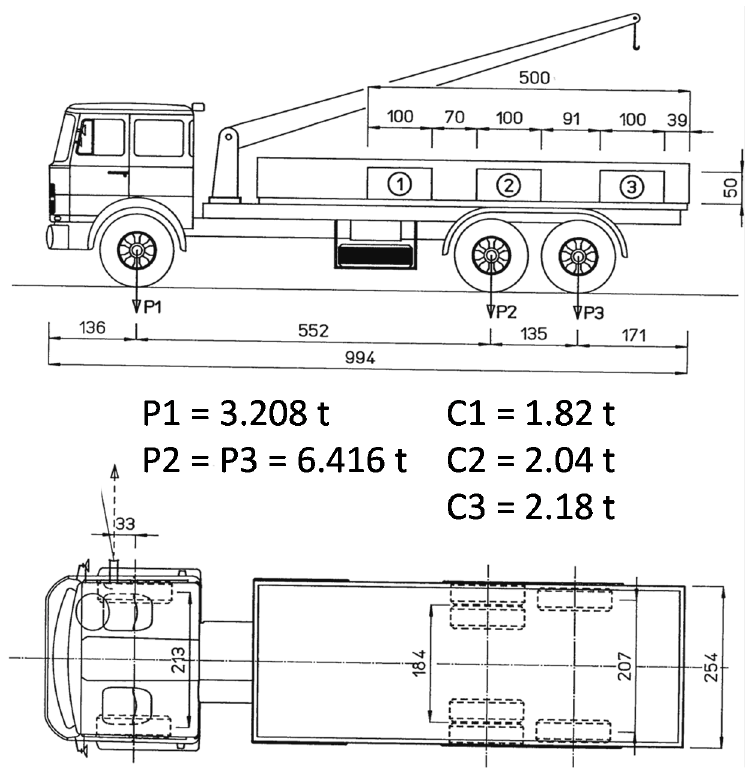
Figure 5. Geometric (in cm) and load characteristics of the test vehicle.